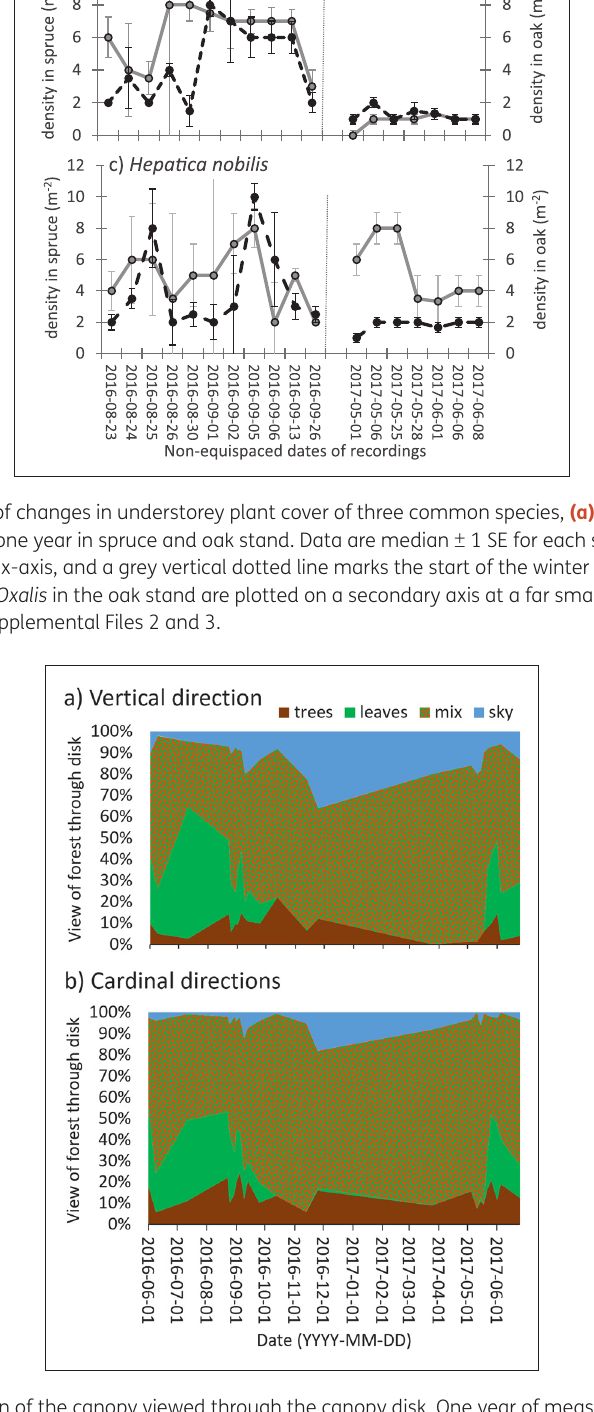
Figure 5 The percentage composition of the canopy viewed through the canopy disk. One year of measurements, twenty-four occasions, at the same location in a Betula sp. stand on Lammi Biological Station Science Trail. (a) Vertical observations looking directly up through the canopy, and (b) “horizontal” cardinal observations, looking at a 45° angle above the horizon in each of the four cardinal